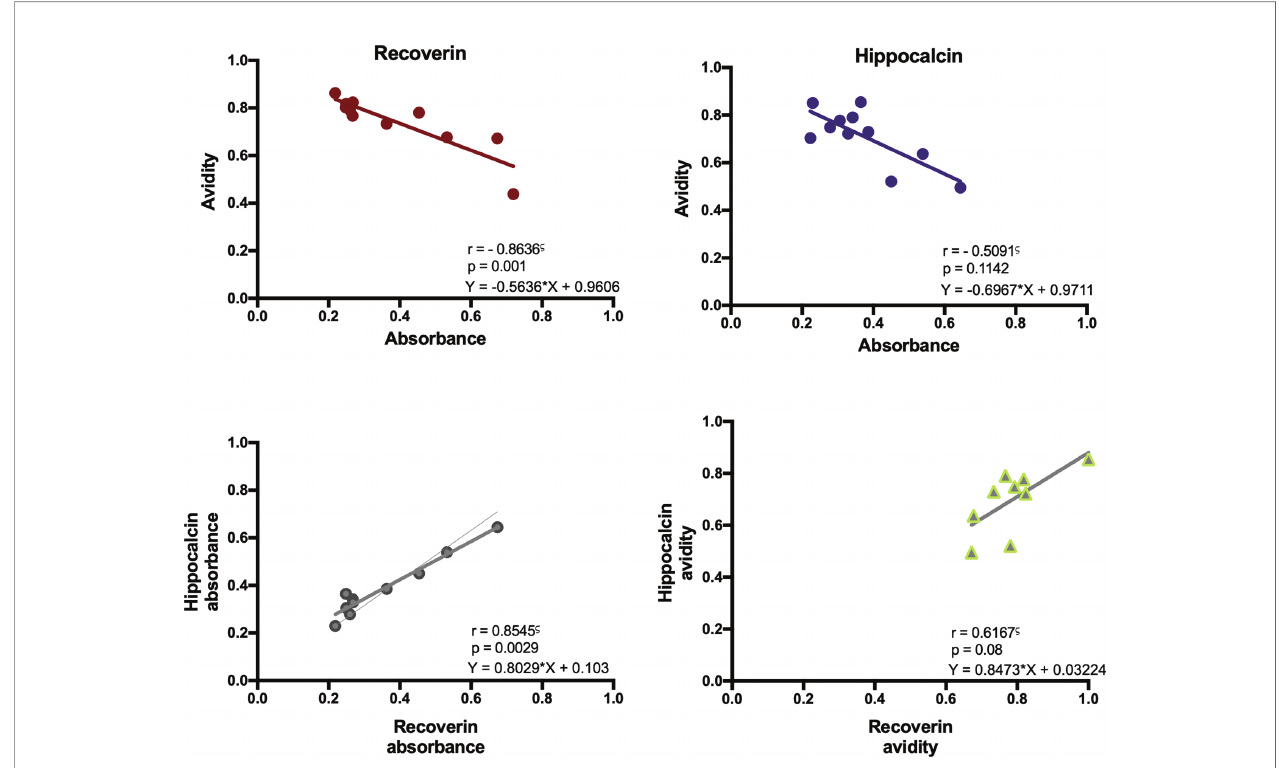
FIGURE 8 | Immunochemical analysis of the anti-recoverin and anti-hippocalcin responses. Correlation between absorbance and avidity for anti-recoverin and anti- hippocalcin. Correlation between absorbance and avidity values to recoverin and hippocalcin. Spearman ’ s correlation